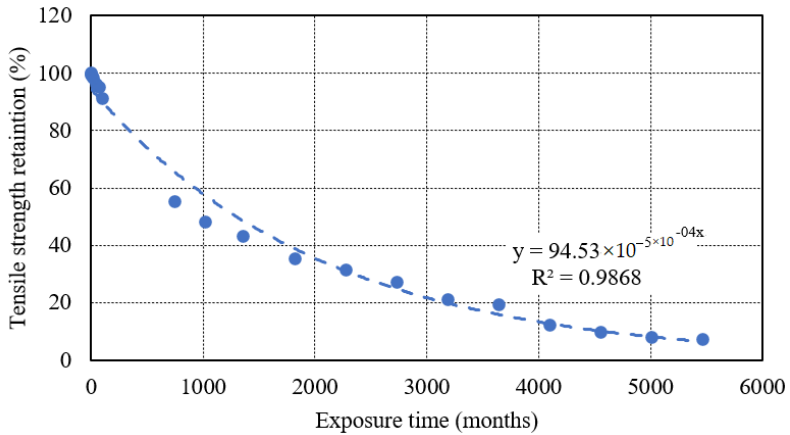
Figure 15. Durability prediction of E-glass epoxy composite immersed in seawater at 23 °C.